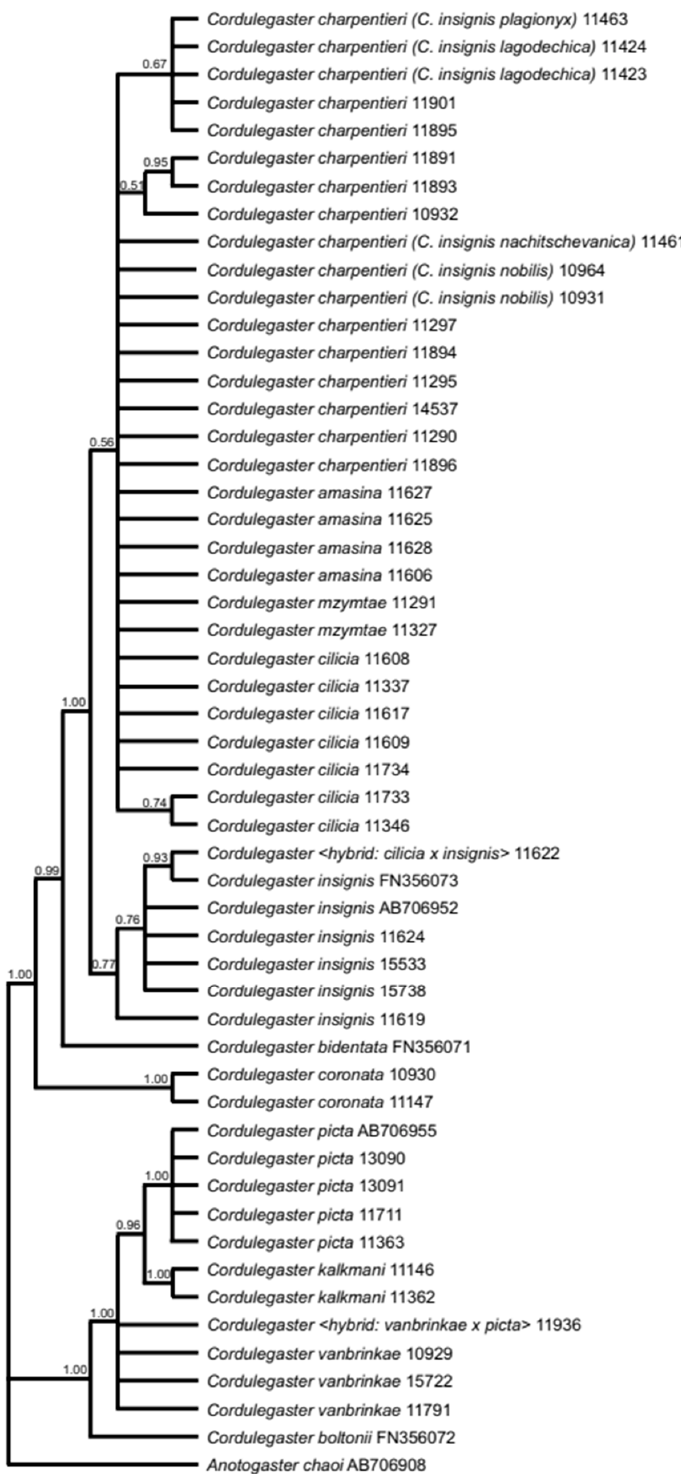
Figure 5. Overview tree from the ITS gene. Maximum likelihood tree inferred with Bayesian analysis using MRBAYES 3.2.7a using the best-fit model (HKY + G) identified with JMODELTEST 2.1.10. Bayesian posterior probabilities values are depicted at the nodes. Included are our isolated sequences (PCR number next to the name) and those retrieved from GenBank (accession numbers next to the name), if specimens identify different taxa in the COI and ITS analysis they are indicating possible hybrids.